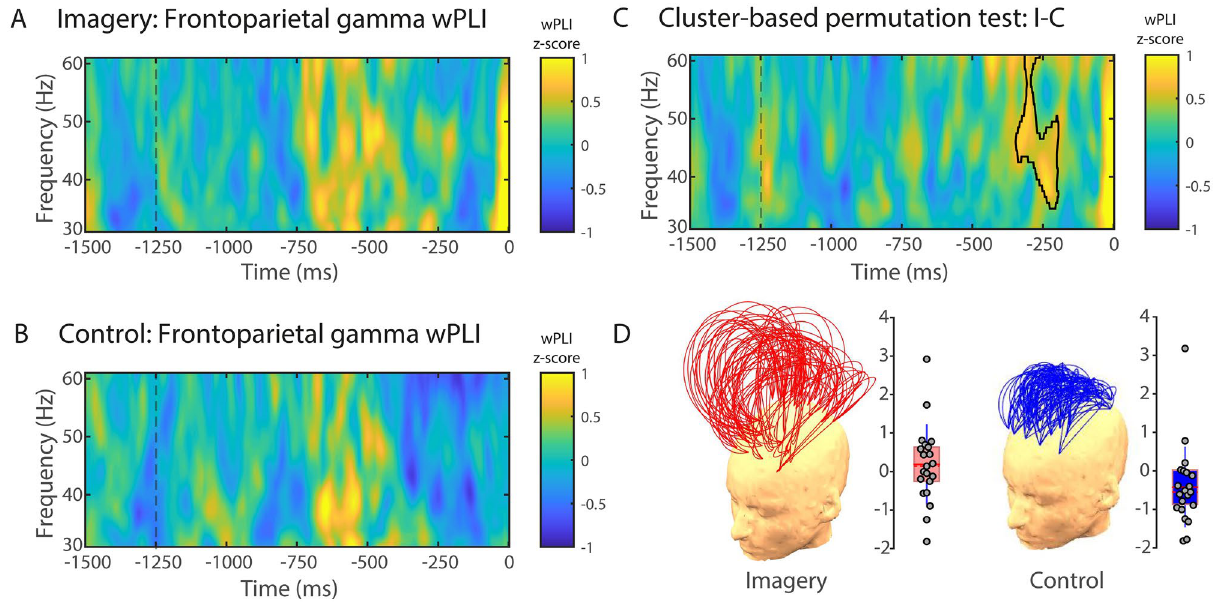
Figure 2. Gamma phase-synchrony between frontal and parietal electrodes. wPLI (30–60 Hz) for visual imagery ( A ) and control ( B ) conditions. ( C ) Cluster-based permutation test comparing visual imagery and control conditions. The area highlighted in the time–frequency chart depicts a significant wPLI cluster between conditions (visual imagery minus control) in the gamma band (30–60 Hz). ( D ) Region of interest (ROI) for phase-synchrony analysis. wPLI values are expressed in standard deviations (z-scores) in reference to the baseline (− 1500 to − 1250 ms). Trial length (− 1500 ms) is relative to response time (0 ms). ( D ) Topographical representation of frontoparietal wPLI channel pairs and single-participant wPLI values for the imagery (left) and control (right) conditions. Each arc represents a pair of channels, and the height of the arc is its normalised value. Grey circles represent single-participant wPLI values for the cluster depicted in ( C ) for the imagery (left panel) and control (right panel) conditions. The red horizontal line represents the group mean, the rectangle represents SEM, and the red-dashed horizontal line represents the group